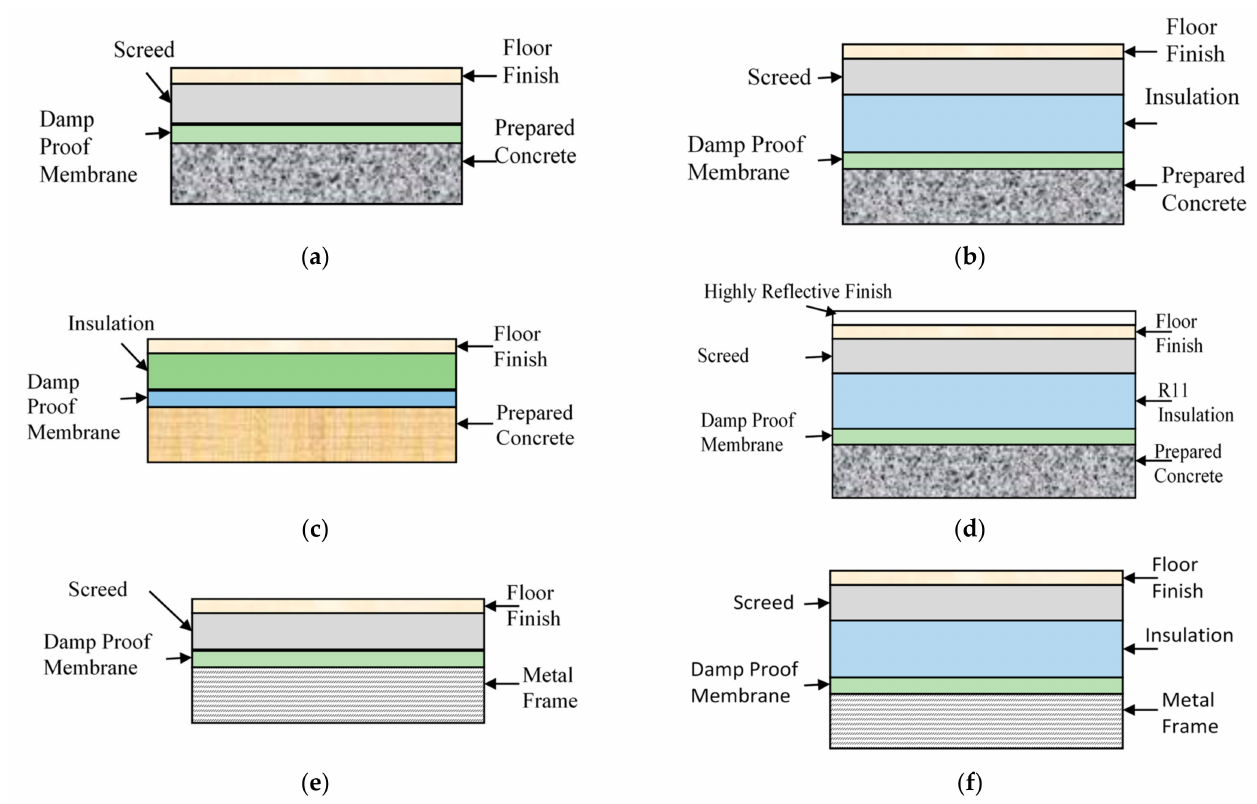
Figure 3. Different types of roof materials for office and warehouse buildings. ( a ) RO1; ( b ) RO2; ( c ) RO4; ( d ) RO5; ( e ) RW5; ( f )